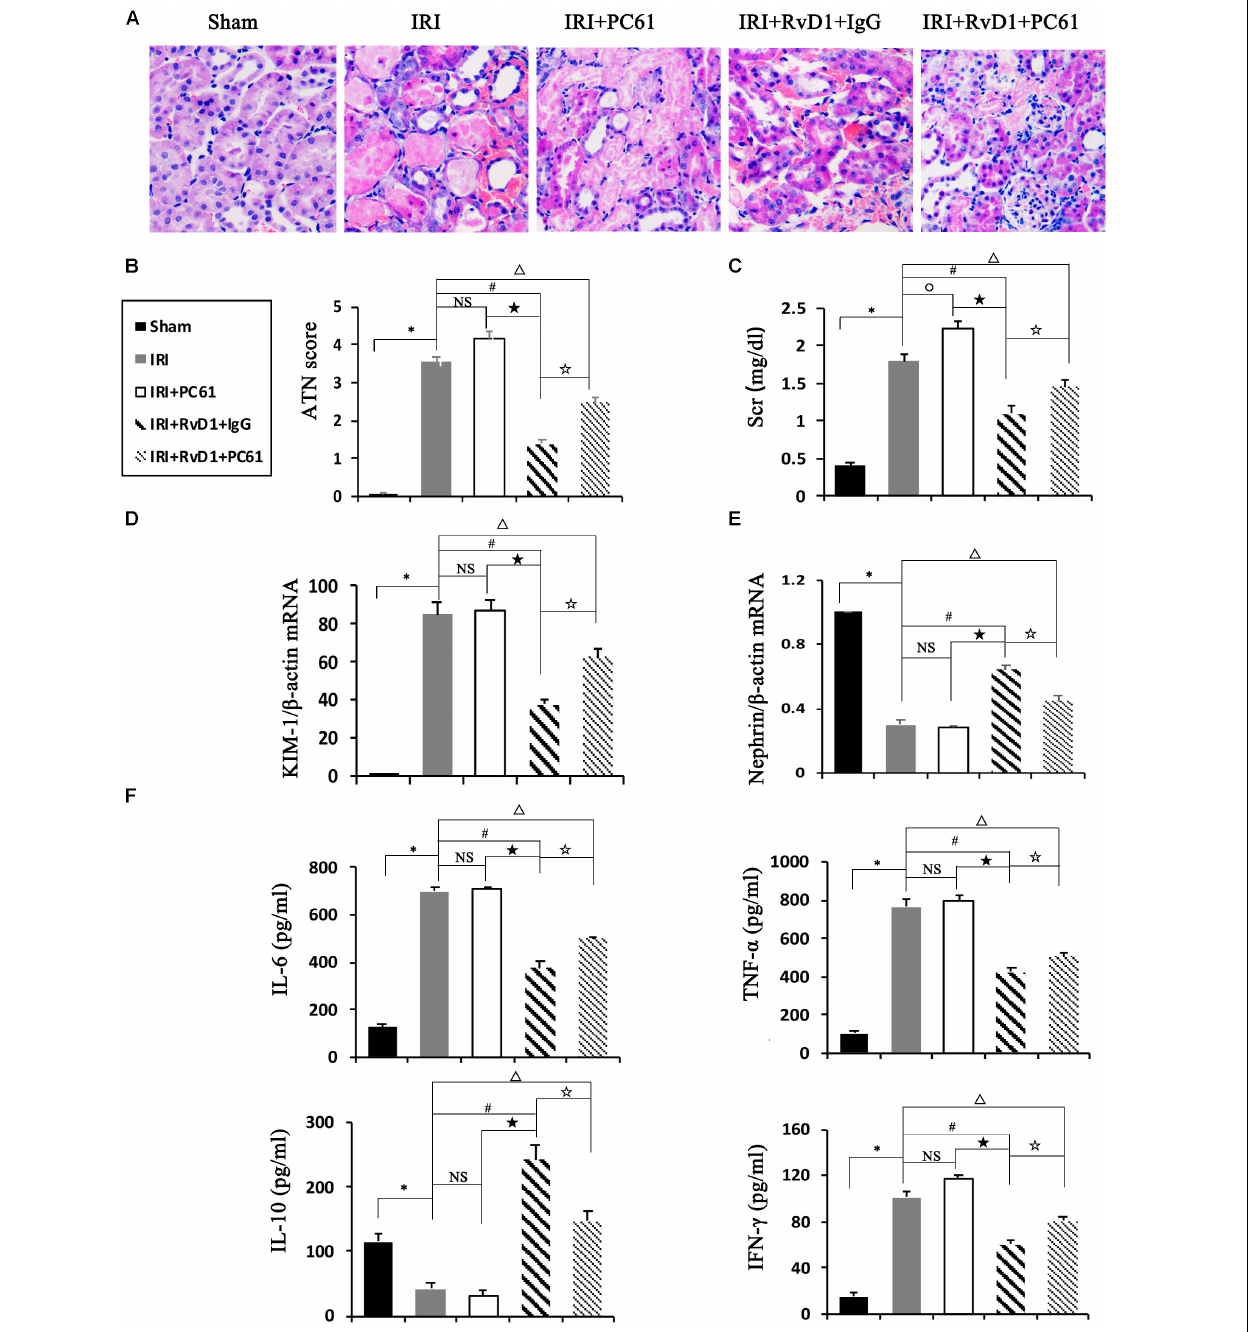
FIGURE 4 | PC61 reversed the beneficial effects of RvD1 on IRI-AKI. (A) Kidneys were stained by PAS (original magnification, 400 × ). (B) ATN scores at 72 h after reperfusion. (C) Serum creatinine levels at 72 h after reperfusion. The relative mRNA expression of KIM-1 (D) and Nephrin (E) at 72 h after reperfusion. (F) Serum IL-6, TNF- α , IL-10 and IFN- γ levels at 72 h after reperfusion as determined by ELISA. Values are expressed as the means ± SDs, n = 6–8 per group. ∗ P < 0.05, IRI (cid:72) (cid:73) versus Sham; # P < 0.05, IRI + RvD1 + IgG versus IRI; P < 0.05, IRI + PC61 versus IRI + RvD1 + IgG; P < 0.05, IRI + RvD1 + IgG versus IRI + RvD1 + PC61; (cid:49) P < 0.05, IRI + RvD1 + PC61 versus IRI; ◦ P < 0.05, IRI + PC61 versus IRI; NS: not significant.